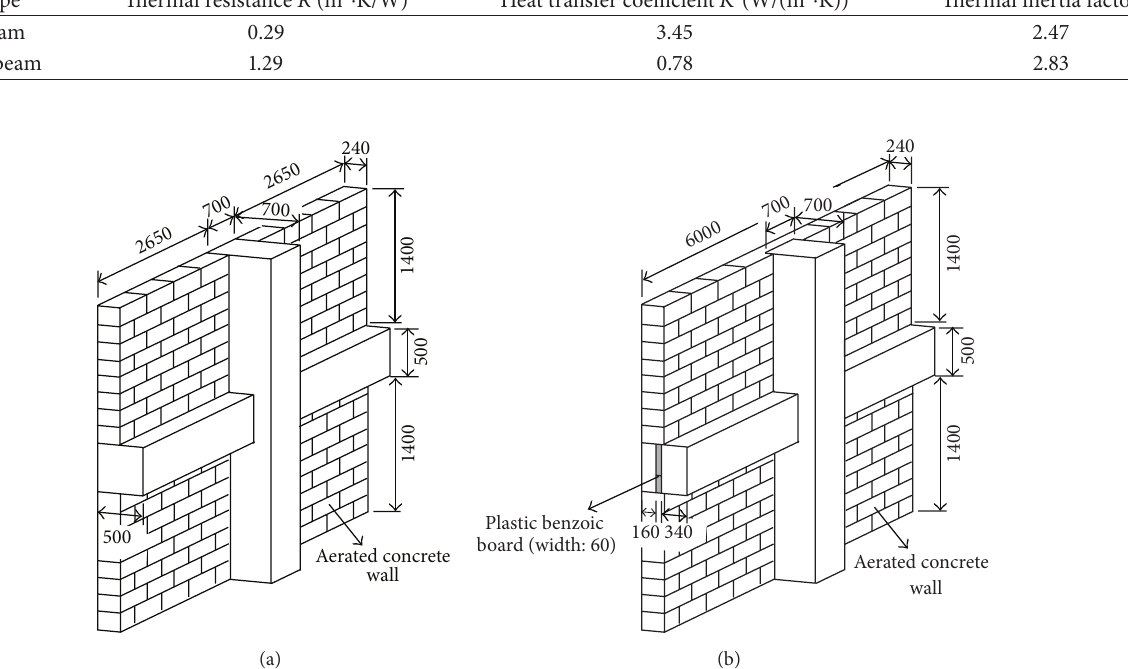
Figure 10: Geometry of the unit frame built in COMSOL Multiphysics: (a) normal frame and (b) frame using the slotted beam-wall system (units: